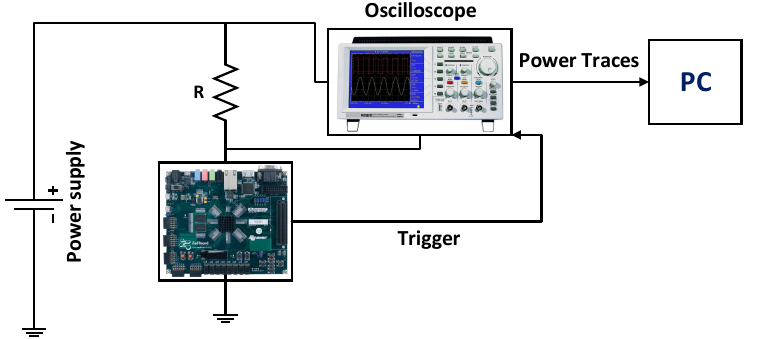
Figure 3. Hardware setup to collect power traces.